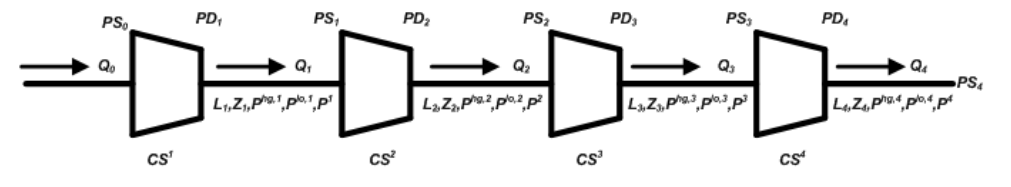
Figure 3. Hypothetical gas